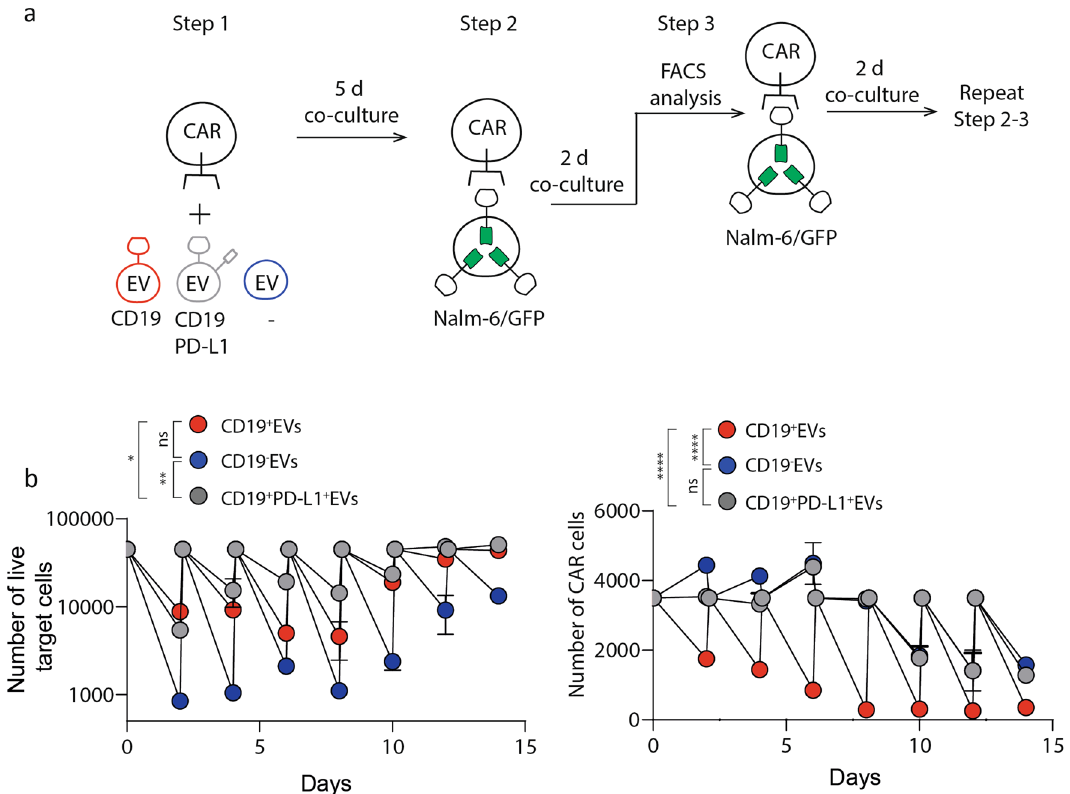
Figure 5. CD19-positive EVs impair killing of target cells by CD19-CAR T cells. A Design of sequential killing experiment. B Sequential killing assay of CD19 + , CD19 + PDL-1 + , CD19 − EVs treated CD19-CAR T cells incubated with Nalm-6 target cells at 1:5 ratio. Target and CAR T cell numbers were analyzed every 2 days by flow cytometry. Remaining CAR T cells were mixed with fresh aliquot of target cells at the same ratio and incubated for another 2 days. The procedure was repeated several times until the day 14. Plots show number of survived target (left) and effector CAR T cells (right). Sequential killing assay started on the day 12 of co-cultivation of CARs with EVs. Data are presented as the mean ± s.d. of three experimental replicates and from at least two independent experiments. Statistical analysis was performed using two-way ANOVA with the Geisser-Greenhouse correction and Tukey’s multiple comparison